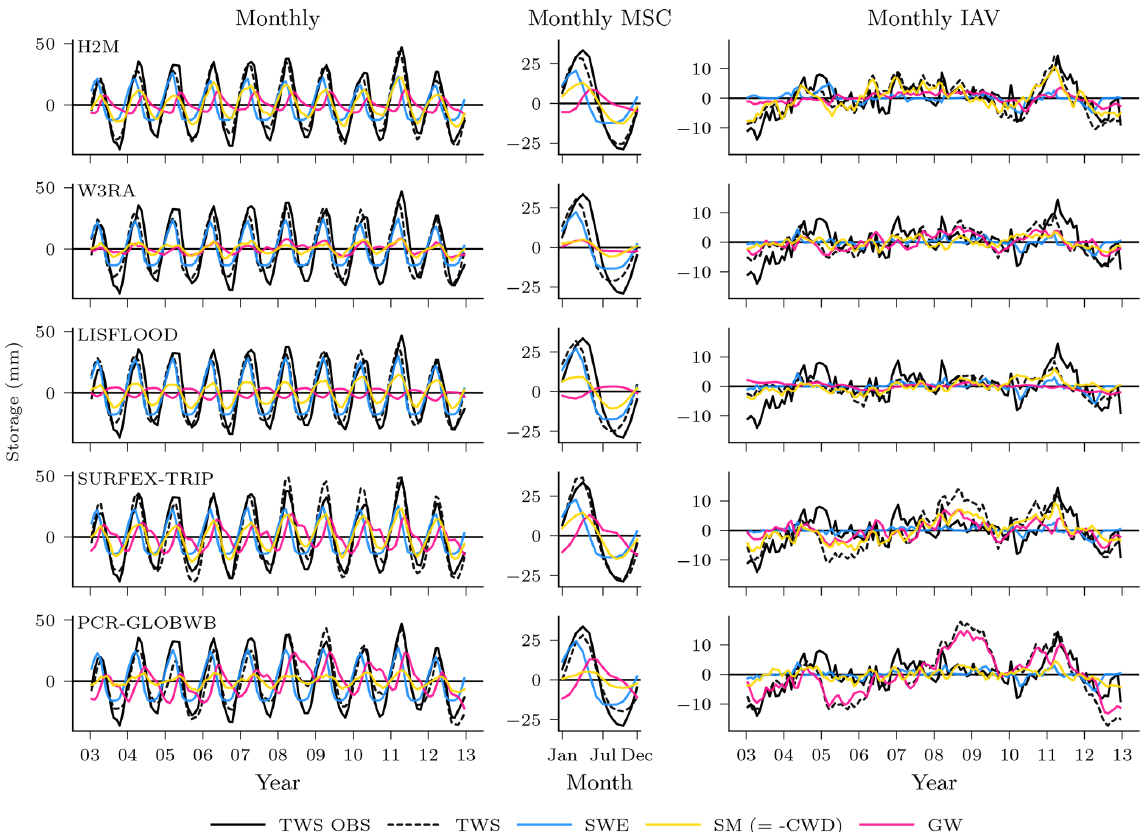
Figure 9. Global variability in the terrestrial water storage (TWS) and the components snow water equivalent (SWE), soil moisture (SM), and groundwater (GW) for the hybrid hydrological model (H2M) and the process-based global hydrological models (rows). Note that SM corresponds to negative modeled cumulative water deficit (CWD) in H2M. For reference, the TWS observations are shown (TWS OBS). The monthly signal (left) and its decomposition into the mean seasonal cycle (MSC; center) and the interannual variability (IAV; right) are arranged in columns. The time series represent the global signal, i.e., the data were aggregated using the cell-size-weighted average per time step, and only cell time steps present in all model simulations were used. The y scale is consistent in columns but varies across the signal components. The training and test period is shown for the complete years 2003 to 2012. Note that surface storage is included in the groundwater component for the models SURFEX-TRIP and